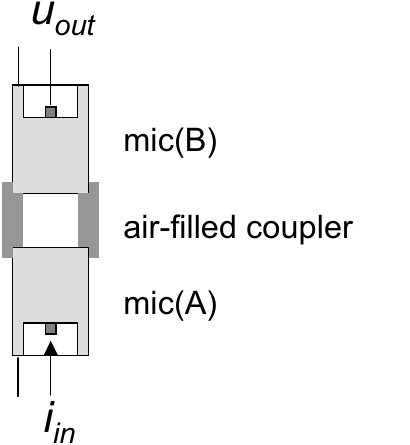
Fig. 4. Microphones coupled by air-filled cavity for pressure response calibration.